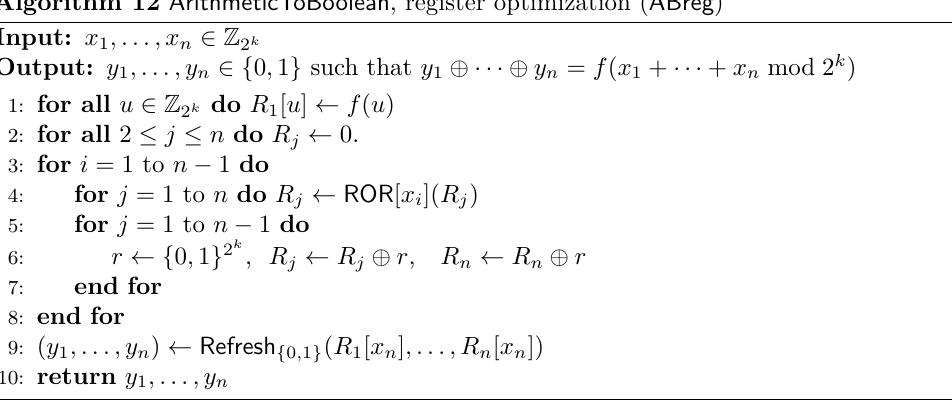
Algorithm 12 ArithmeticToBoolean , register optimization ( ABreg